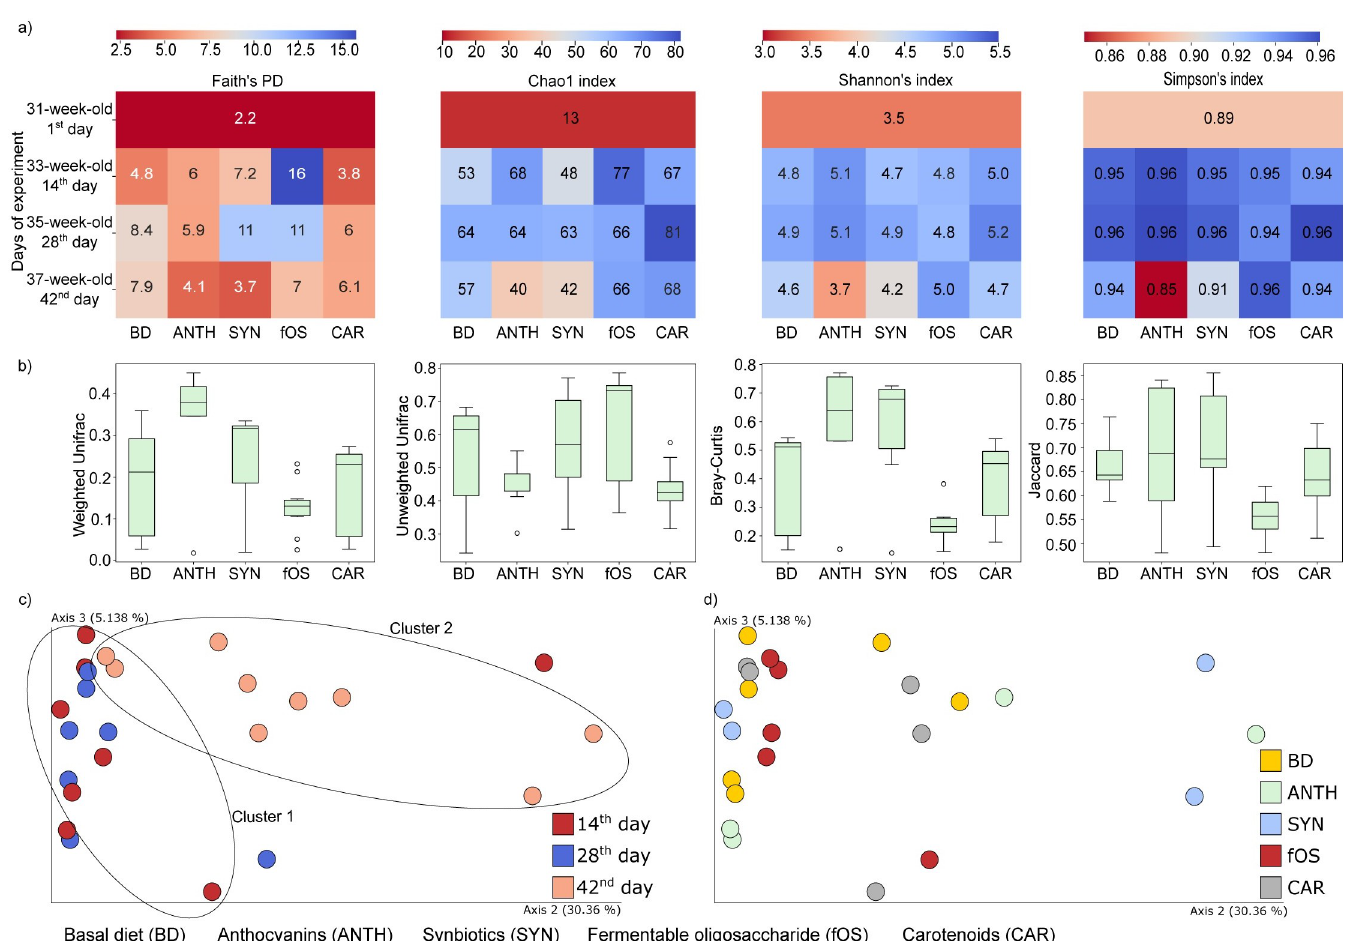
Fig 3. Alpha diversity metrices used in the comparison analysis. a) Annotated heatmaps showing the values of Faith’s PD, Chao-1, Shannon’s and Simpson’s diversity indexes as a function of the time of sample collection (y axis) and the experimental settings (x axis). b) The sample distances were calculated based on quantitative (Bray- Curtis, weighted UniFrac) and qualitative (Jacquard, unweighted UniFrac) dissimilarity-based statistics c, d) Weighted UniFrac analysis was performed to identify ageing- and treatment-driven differences between the groups. The beta diversity relationships are summarized in two-dimensional scatter plots. The distances between dots are representative of differences in microbiota compositions. BD represents fish that received a basal diet, which served as a negative control with no dietary supplement or the following dietary treatments as supplemented feed: BD+1% anthocyanins (ANTH) provided by Hungarian sour cherry extract, BD+1% synbiotics (SYN) provided by fermented corn, BD+1% fermentable oligosaccharides (fOS) provided by Hungarian sweet red pepper seed extract, and BD+1% carotenoids (CAR) provided by Hungarian sweet red pepper pulp extract.